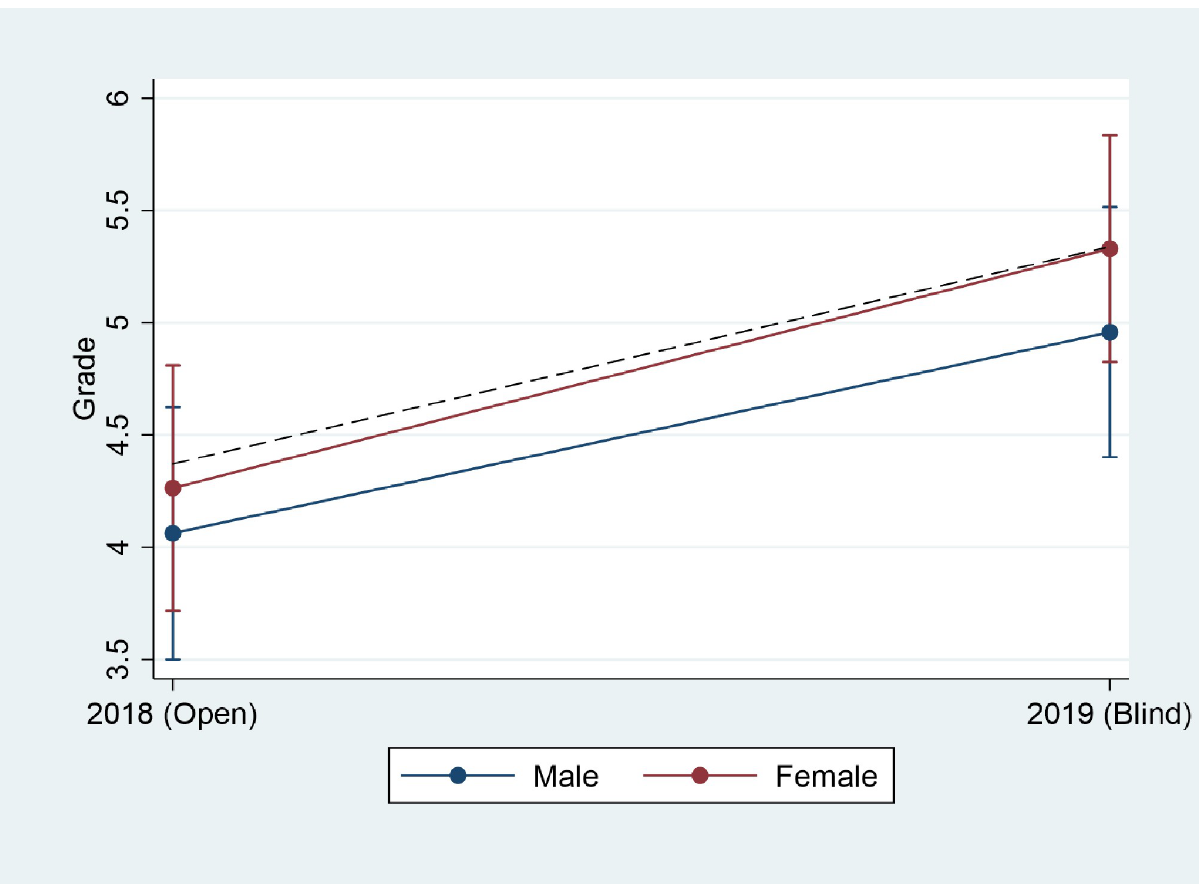
Fig 1. Gender bias. The dashed line represents the predicted grades of students with female names with no gender bias.